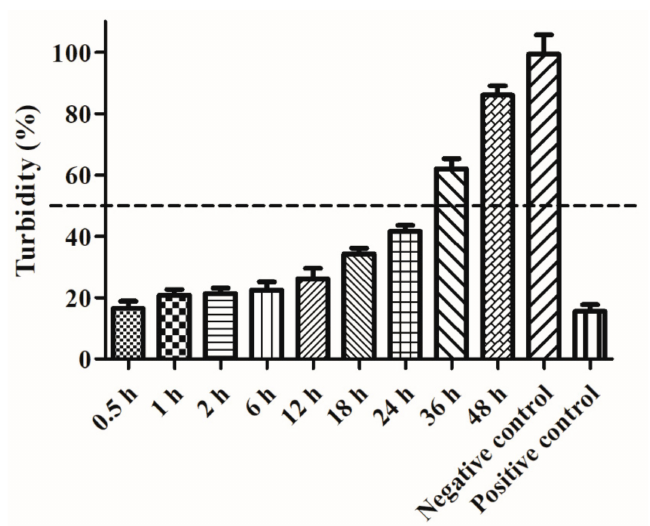
Figure 3. Turbidity (the OD600 after 30 min / original OD600) reduction of S. suis cell suspensions (strain HA9801) after preincubation of Ply5218 in piglet serum. Serum was collected from healthy piglets and incubated with Ply5218 at 37 ◦ C. Turbidity reduction of HA9801 treated with the Ply5218 / serum mixture was measured after 30 min incubation. The data shown are means ± SEMs from at least three independent experiments.